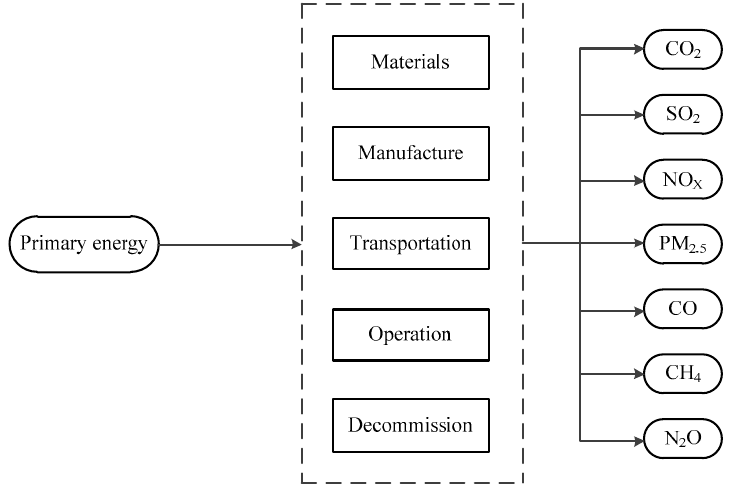
Figure 5. Goal and system boundary of the life cycle assessment (LCA) analysis.